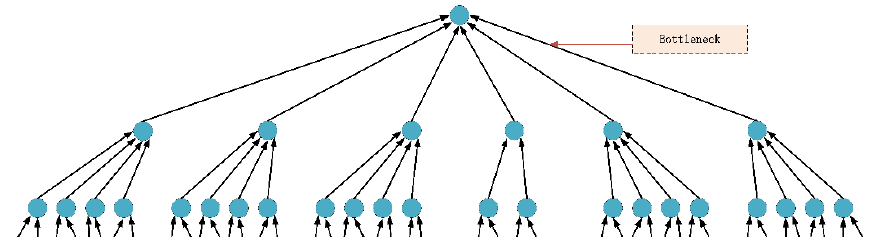
Figure 7. The bottleneck of graph neural networks.